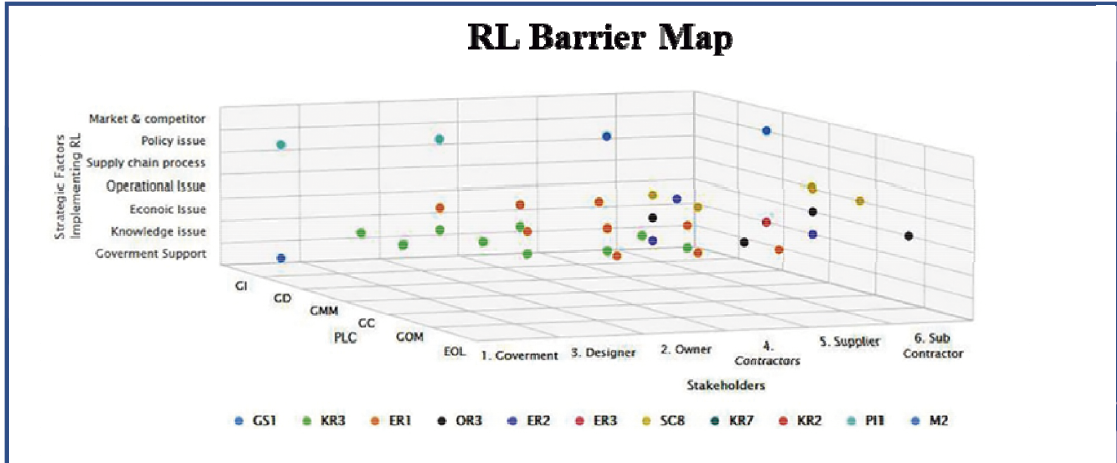
Figure 8. Illustration from RL barriers identification